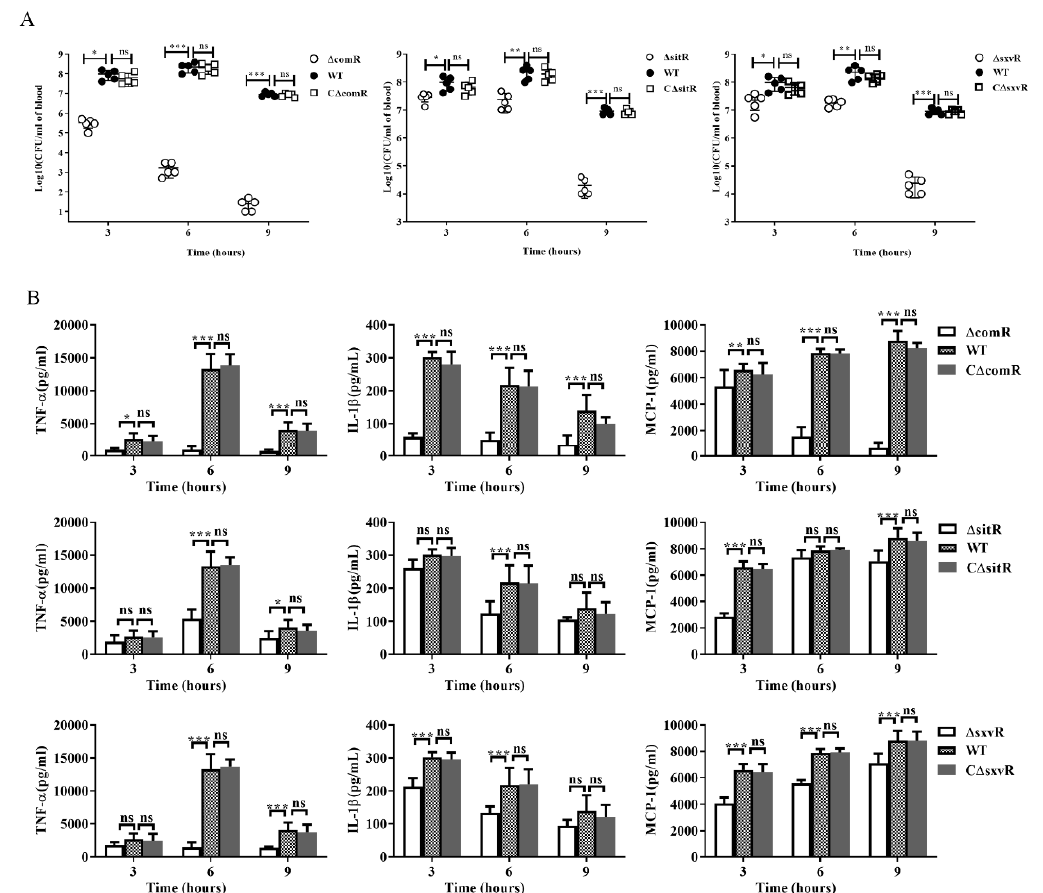
Figure 5. Bacterial loads and cytokine concentrations in the blood of mice after SS2 infection. Female C57BL / 6 mice were challenged with 2 × 10 8 CFU of WT, ∆ comR , C ∆ comR , ∆ sitR , C ∆ sitR , ∆ sxvR or C ∆ sxvR strains cultured on tryptic soy agar. After infection for 3, 6, or 9 h, an equal number of mice in each group were sacrificed to collect blood. ( A ) Bacteria loads in the blood were examined by determining CFU counts. The results shown are representative of three independent experiments. ( B ) Blood cytokine concentrations were determined by enzyme-linked immunosorbent assay. * p < 0.05, ** p < 0.01, *** p < 0.001, ns means no significance.